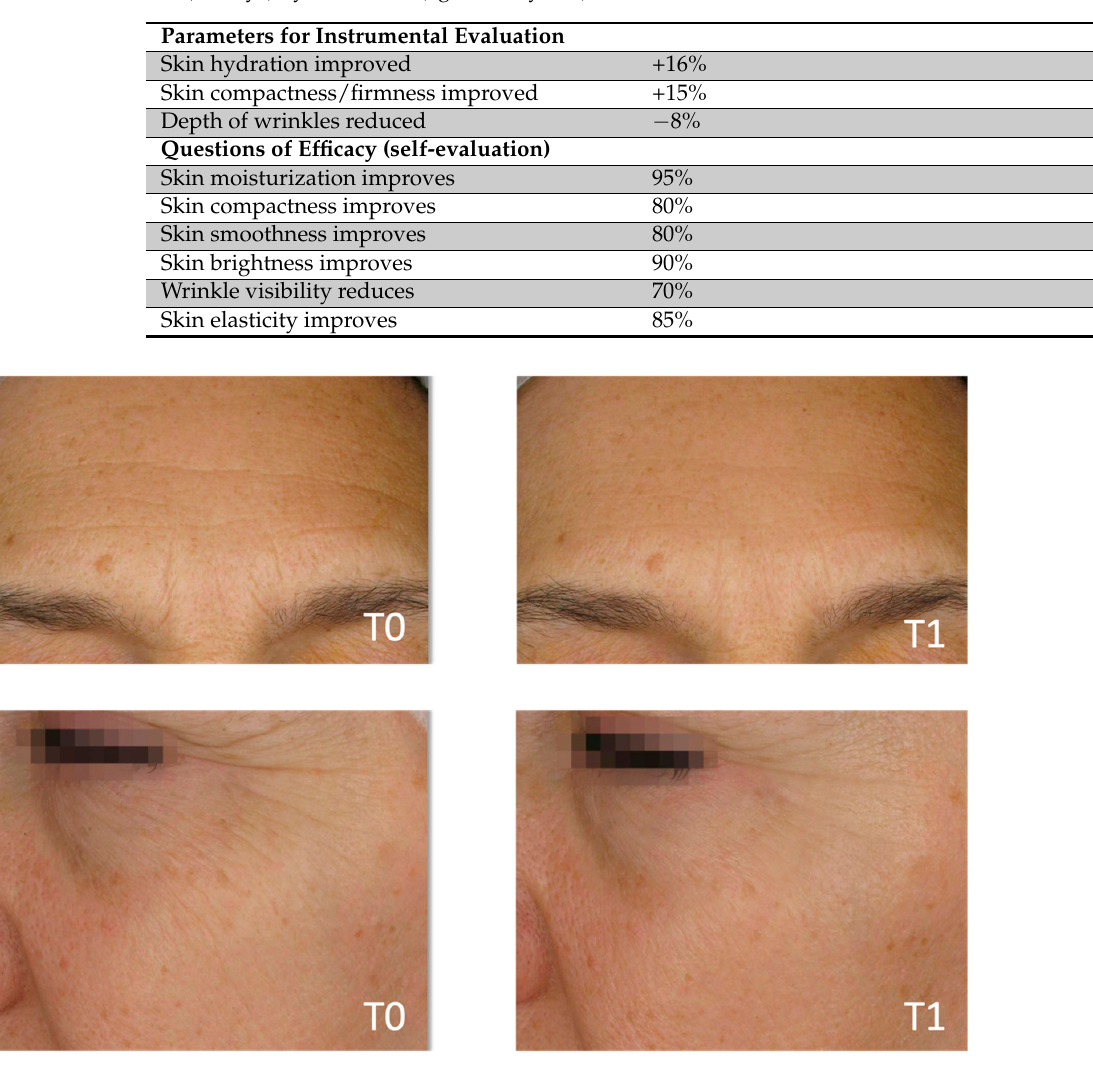
Table 1. Results of the efficacy—instrumental evaluation and self-evaluation by questionnaire after use (28 days) by 20 women (age 40–70 years).